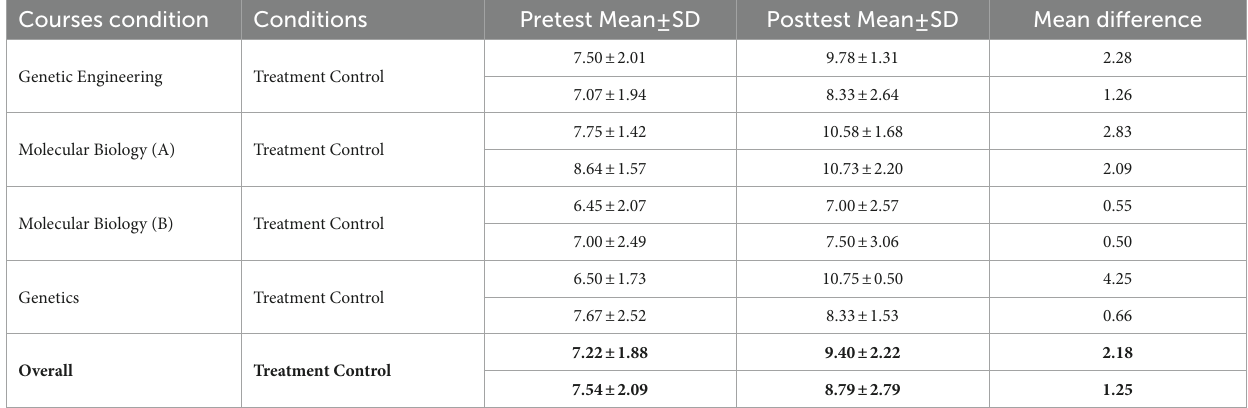
TABLE 1 Mean and standard deviation of the students’ Pretest and Posttest scores (average number of correct questions) on the four different classes evaluated in this study. Courses